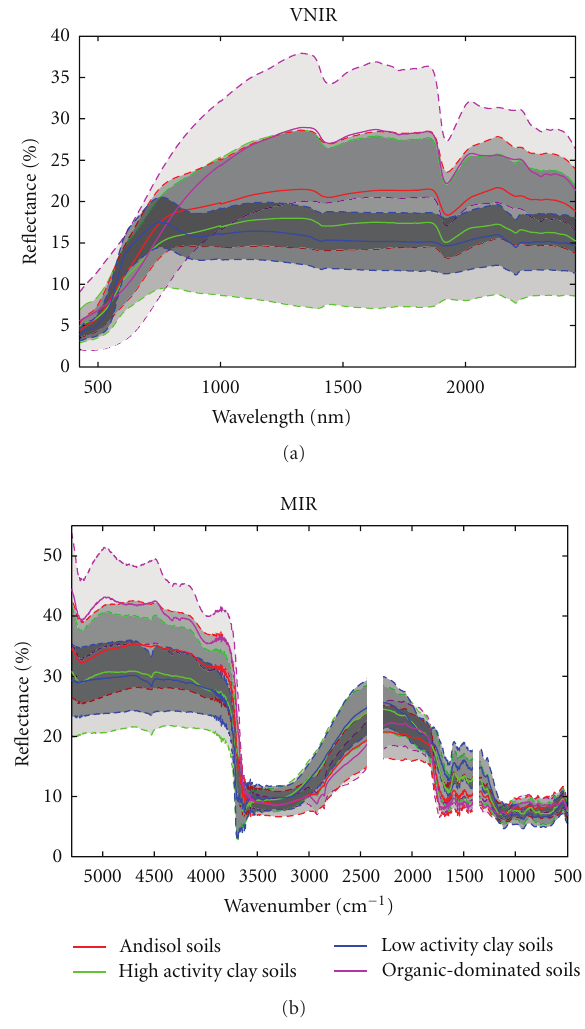
Figure 2: Average (a) visible/near-infrared (VNIR) and (b) mid- infrared (MIR) di ff use reflectance spectra of soil groups used in sub- setting by soil order. Dashed lines represent one standard deviation from the